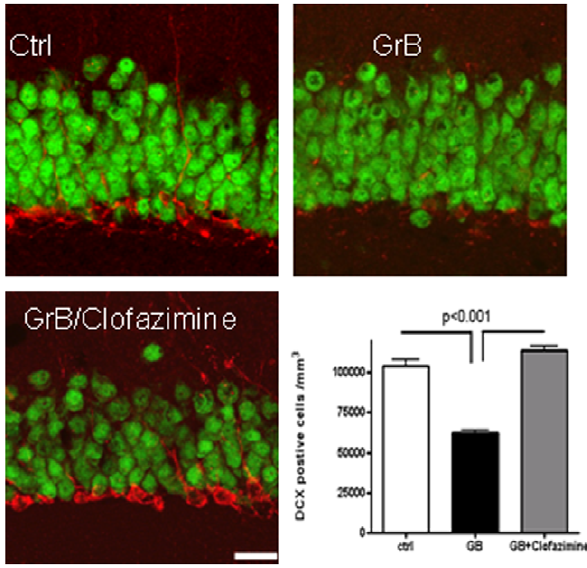
Figure 7. Clofazimine protected against GrB toxicity in hippocampal neurons in vivo . Eight-week-old female Sprague- Dawley rats were stereotaxically injected in the hippocampal dentate gyrus (DG). Group I (n=5) received GrB injection in the DG and clofazimine (50 m g/kg/day) intraperitoneally for ten days (three days before and seven days after the GrB injection). Group II (n=4) received GrB (1 m g/ m l) injection in the DG and vehicle by intraperitoneal injection. Group III (n=4) received control solution both by DG injection and intraperitoneally. Brain sections were then immuno- stained for DCX-positive cells (red) in rat DG. DCX-positive cells were then counted and presented as average 6 SEM.